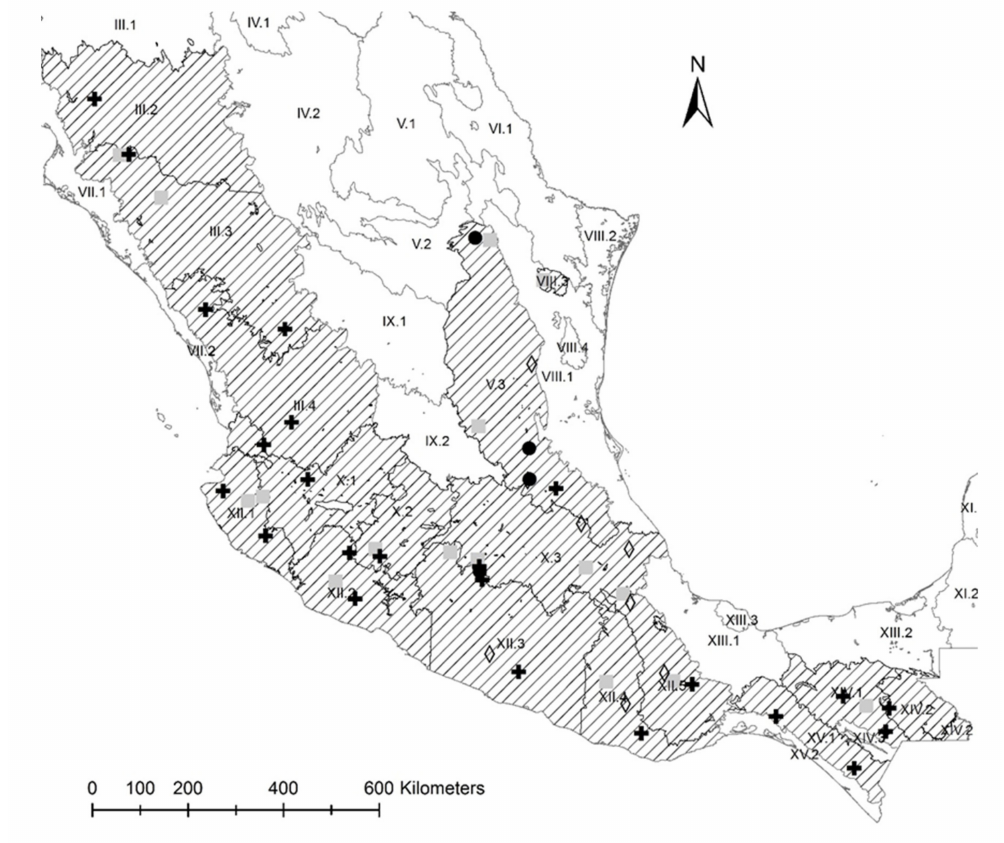
Figure 2. Conservation units proposed by genetic zones (striped polygons) for four Mexican pine species: Pinus greggi (black dots), P. oocarpa (black crosses), P. patula (unfilled diamonds) and P. pseudostrobus (grey